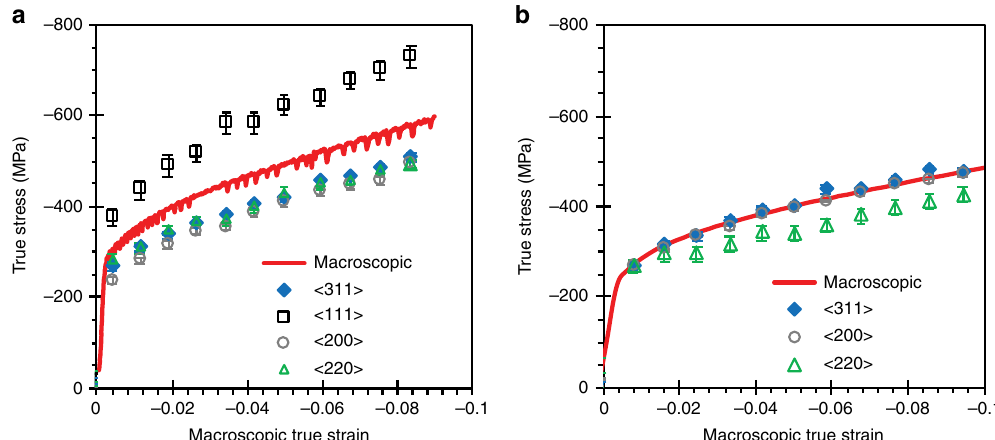
Fig. 5 Grain-level stress – strain curves for conventionally processed and additively manufactured Inconel 625. Grain orientation ( hkl )-dependent effective stress along the loading direction as a function of macroscopic true strain for a CP-IN625 and b AM-IN625 deformed at 600 °C compared to the respective macroscopic stress – strain curves. Error bars are obtained based on the uncertainties in the lattice strain